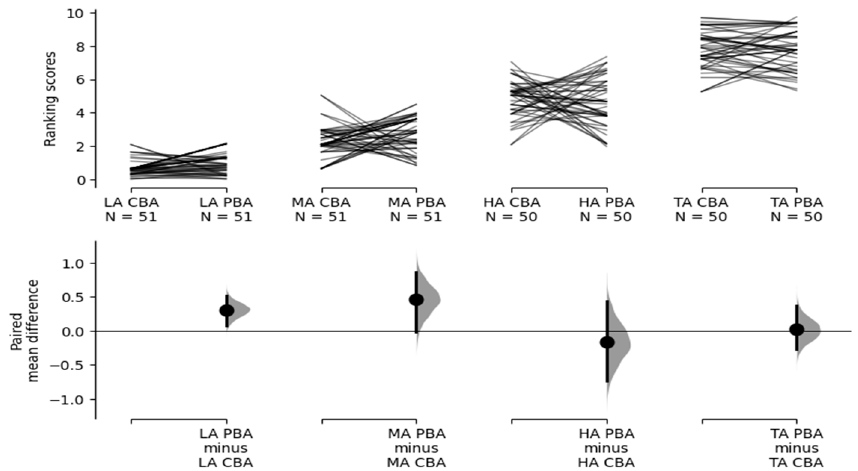
Figure 6. Gardner–Altman estimation plot for the paired mean difference between PBAs and CBAs rank scores in science subjects of 51 low-achievers (LA), 51 medium-achievers (MA), 50 high-achievers (HA) and 50 top-achievers (TA).